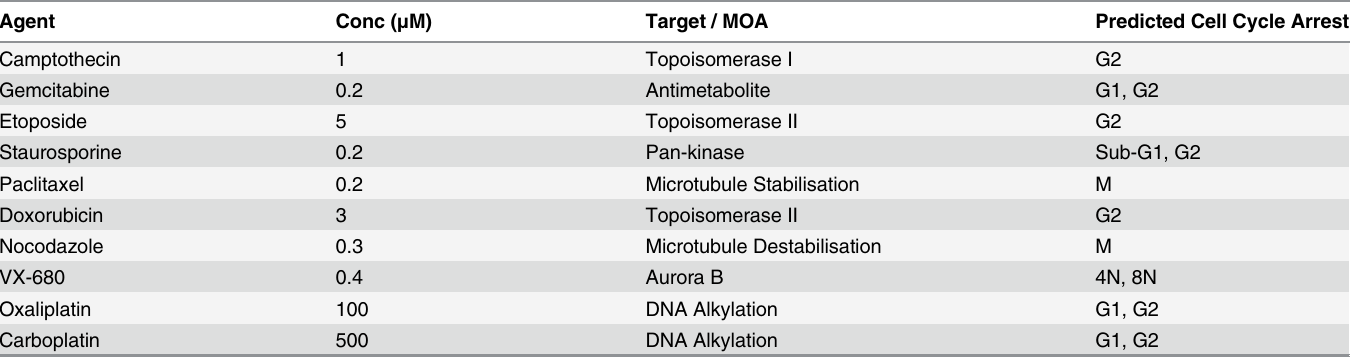
Table 1. Agents used to validate image analysis